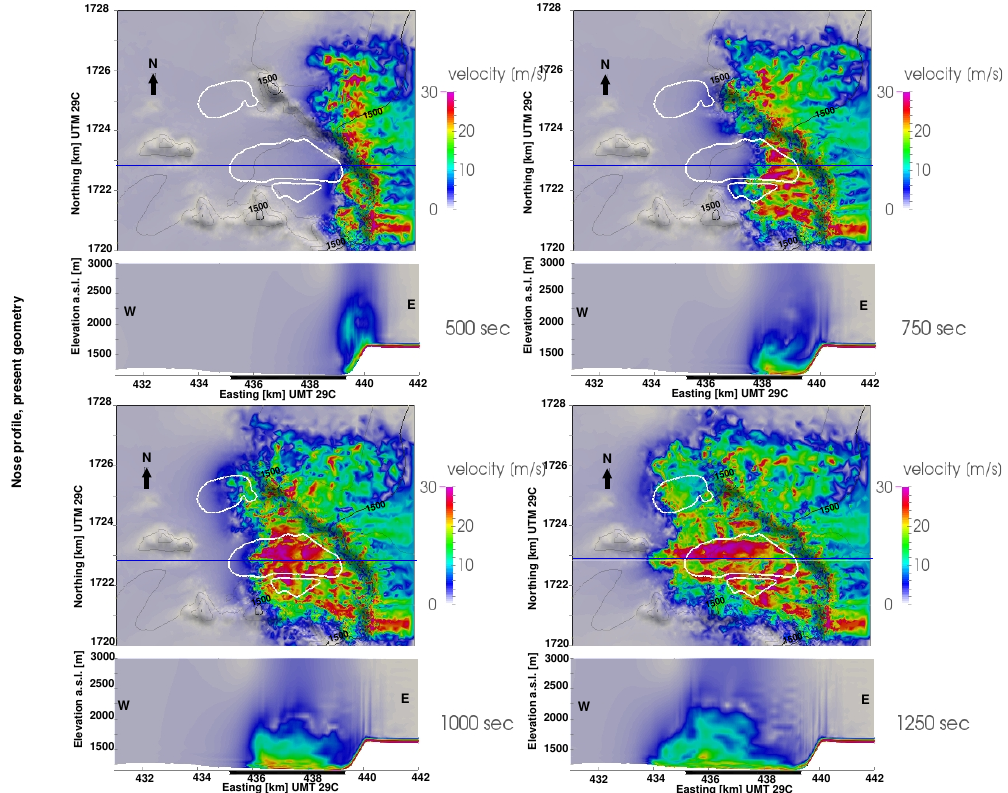
Figure 8. Velocity magnitude 5m above the surface and in a vertical cross section from east to west through the valley (marked by the horizontal blue line in plan views). Results from the simulation using the nose profile (Eq. 5) displayed at 500, 750, 1000 and 1250s into the simulation. The white lines in the plan views and the black bar under the cross sections denote the positions of the BIAs. The cross sections are stretched vertically by a factor of 2. The velocity scale is truncated at 30ms − 1 .